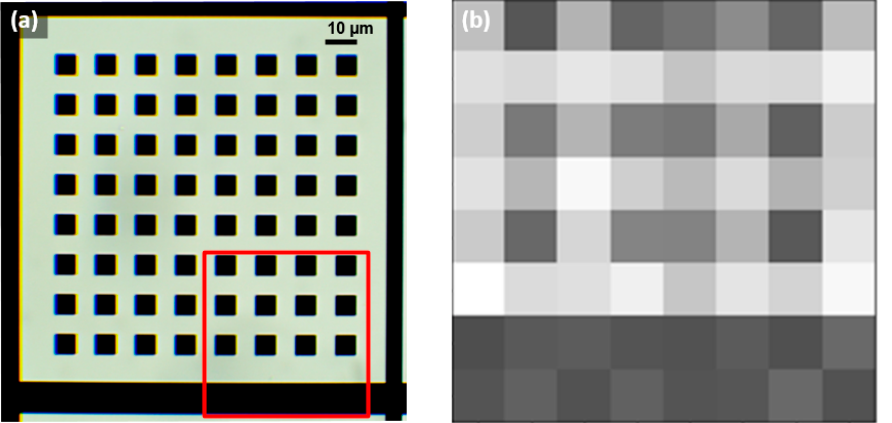
Figure 8. ( a ) Optical image of the EBL pattern of 6.4 µm squares regular spaced at 6.4 µm, with the observed region highlighted in red. ( b ) Image reconstructed with the microscope prototype based on the 8 × 8 5 µm LED array chip (Led1), which presented aliasing, indicating the limit to observe periodic objects of sizes comparable to the LED.